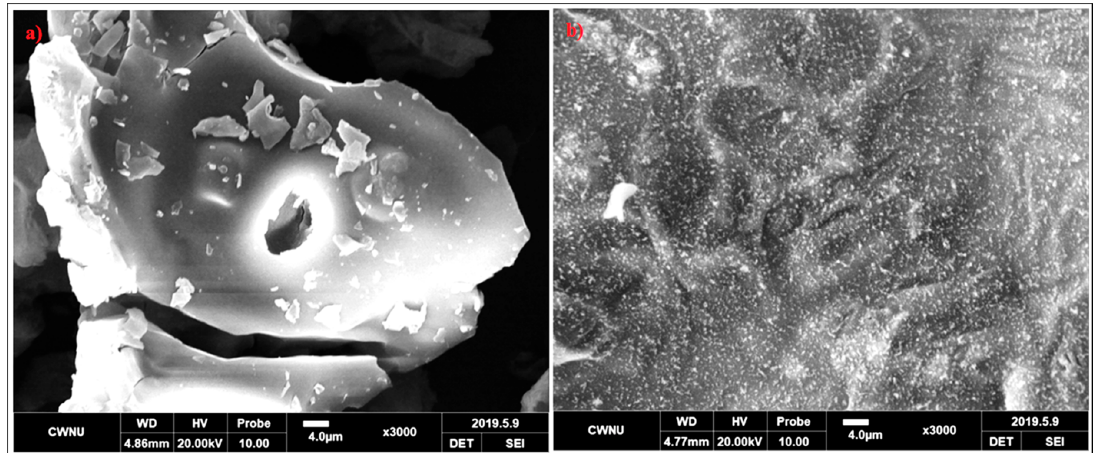
Figure 12. SEM images of the charred layers of Ep/IFR ( a ) and Ep/IFR/ZnO-3% ( b ). Both images were taken at a magnification of 3000.